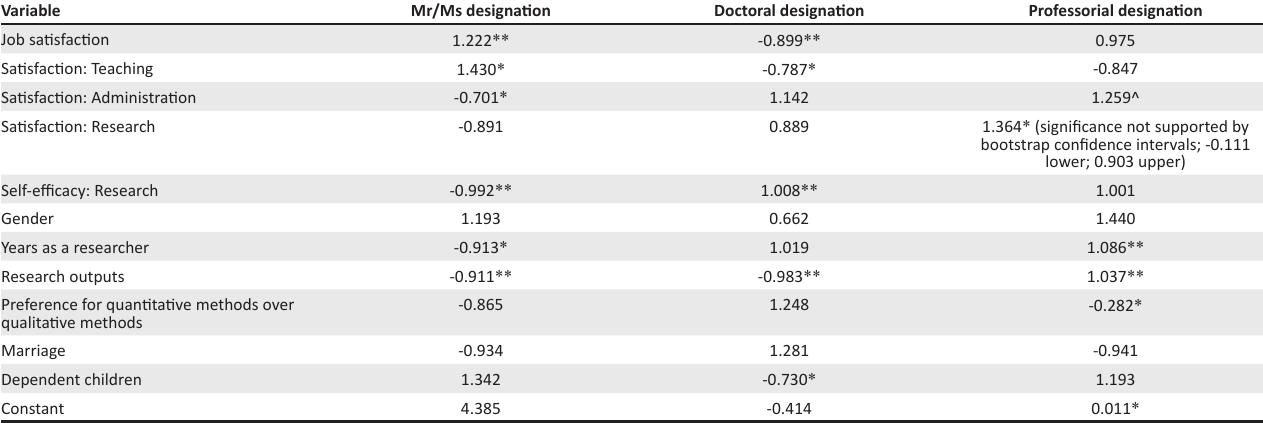
TABLE 4: Exponentiated coefficient comparisons across designation groups.